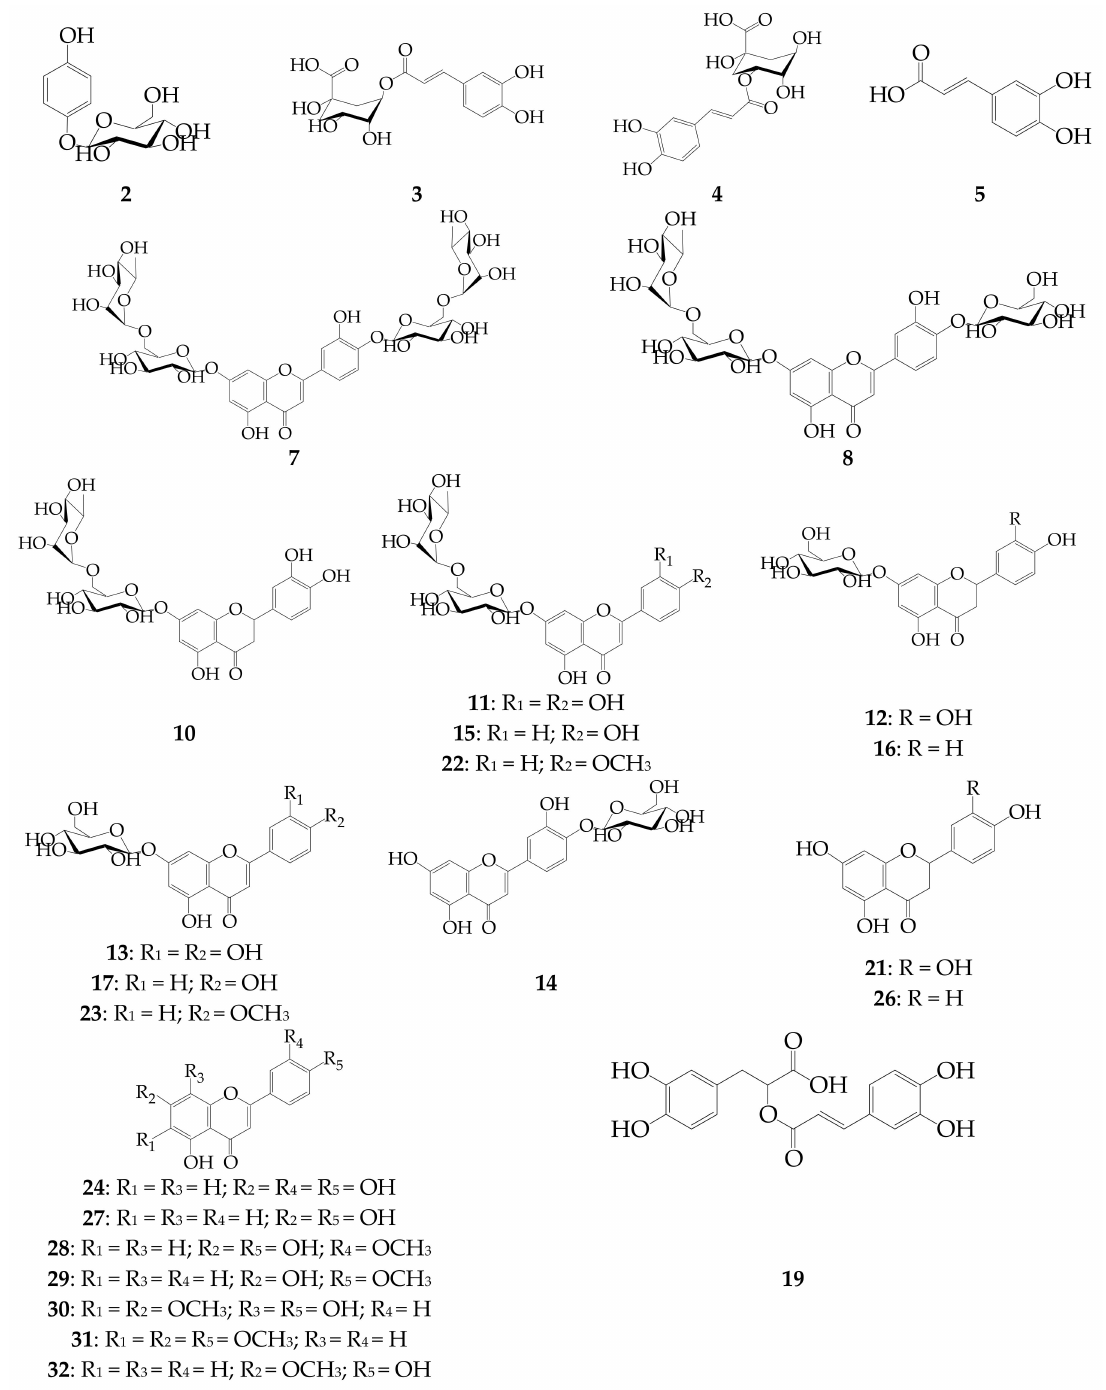
Figure 2. Structures of phenolic compounds 2 – 5 , 7 , 8 , 10 – 17 , 19, 21 – 24 , and 26 – 32 detected in D. palmatum